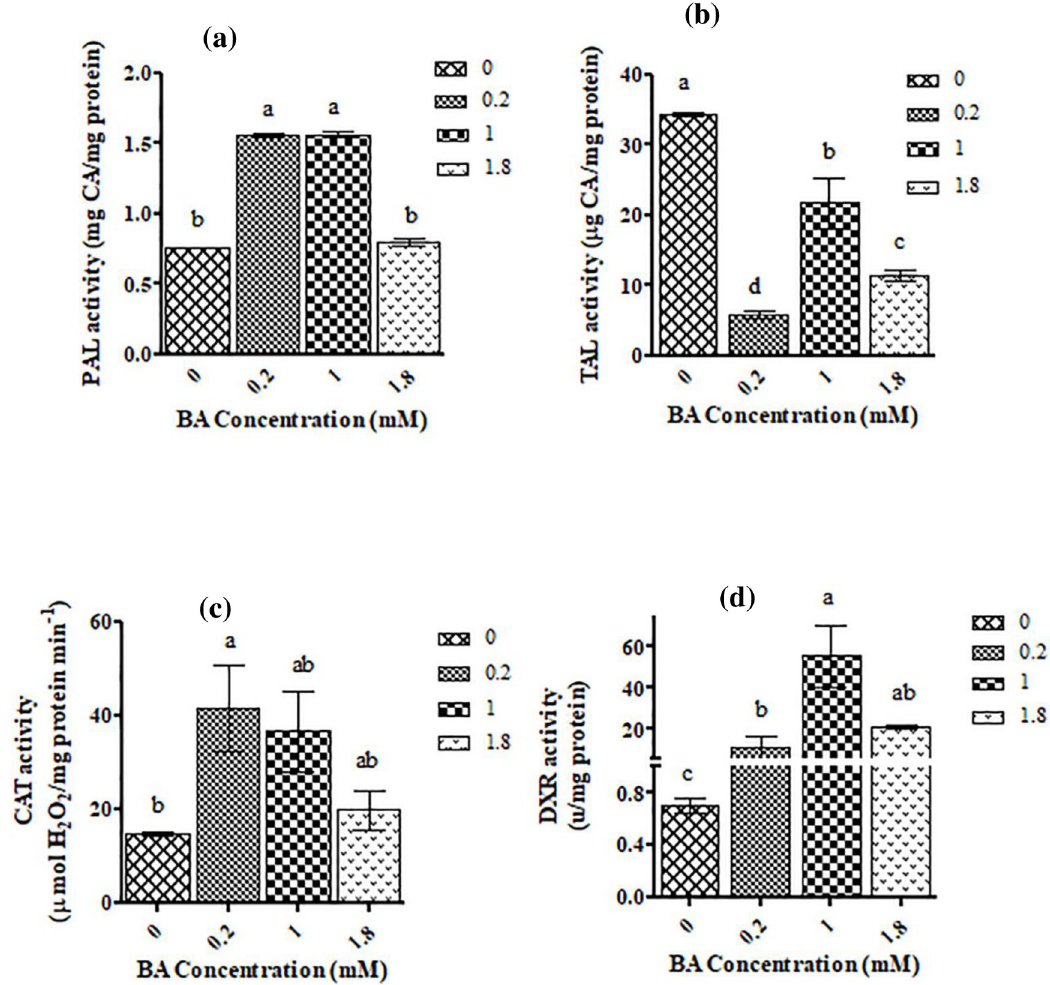
Fig 2. The activity of key enzymes PAL. (a), TAL (b), CAT (c) and DXR (d) involved in signaling molecules, phenolics, and terpenoids metabolism in C . tarraconensis treated with different concentrations of BA. Data are presented as mean ± SD, n = 3. Different letters show significant differences at P < 0.05 according to Duncan